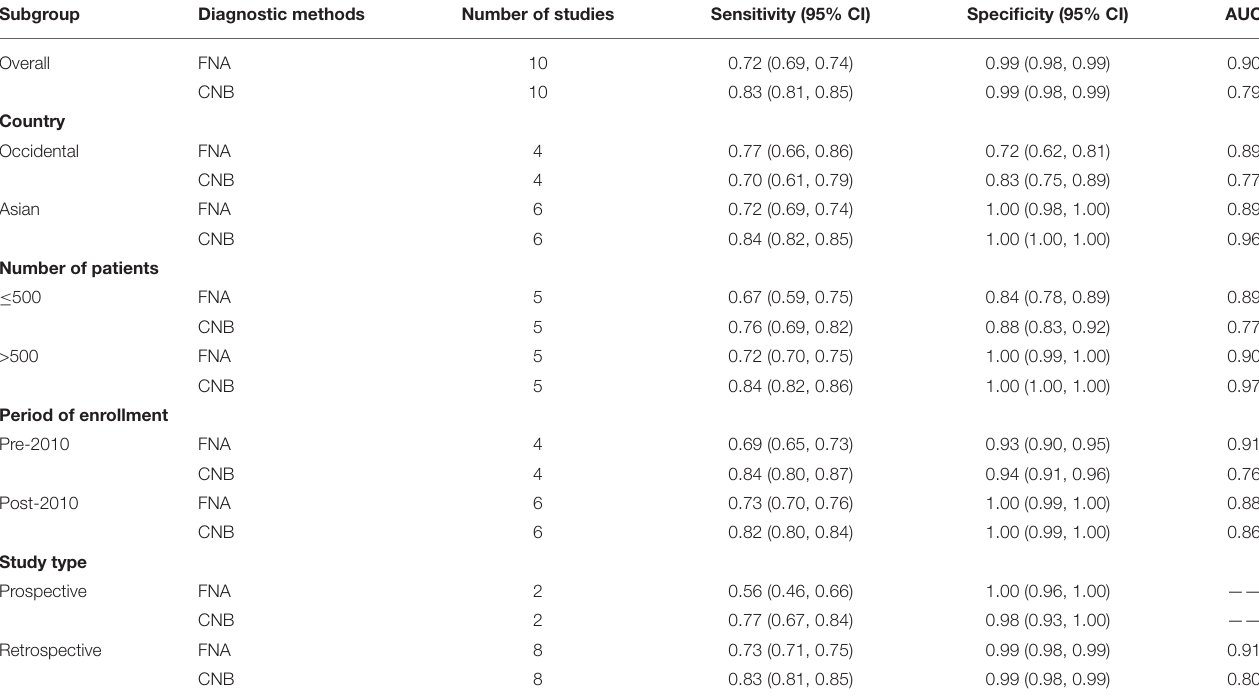
TABLE 4 | Subgroup analysis of diagnostic effect.